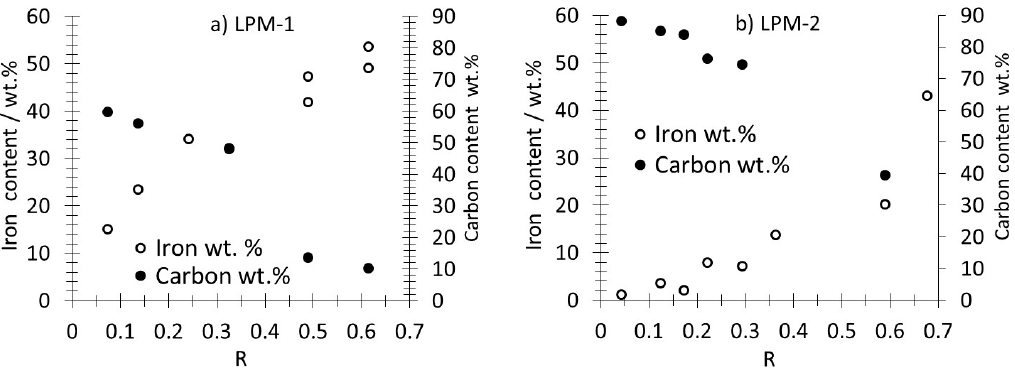
Figure 5. Carbon and iron contents as a function of R for nanomaterials prepared using ( a ) FeOOH (LPM-1) and ( b ) iron III acetylacetonate (LPM-2). Empty and filled symbols correspond to iron and carbon contents, respectively.